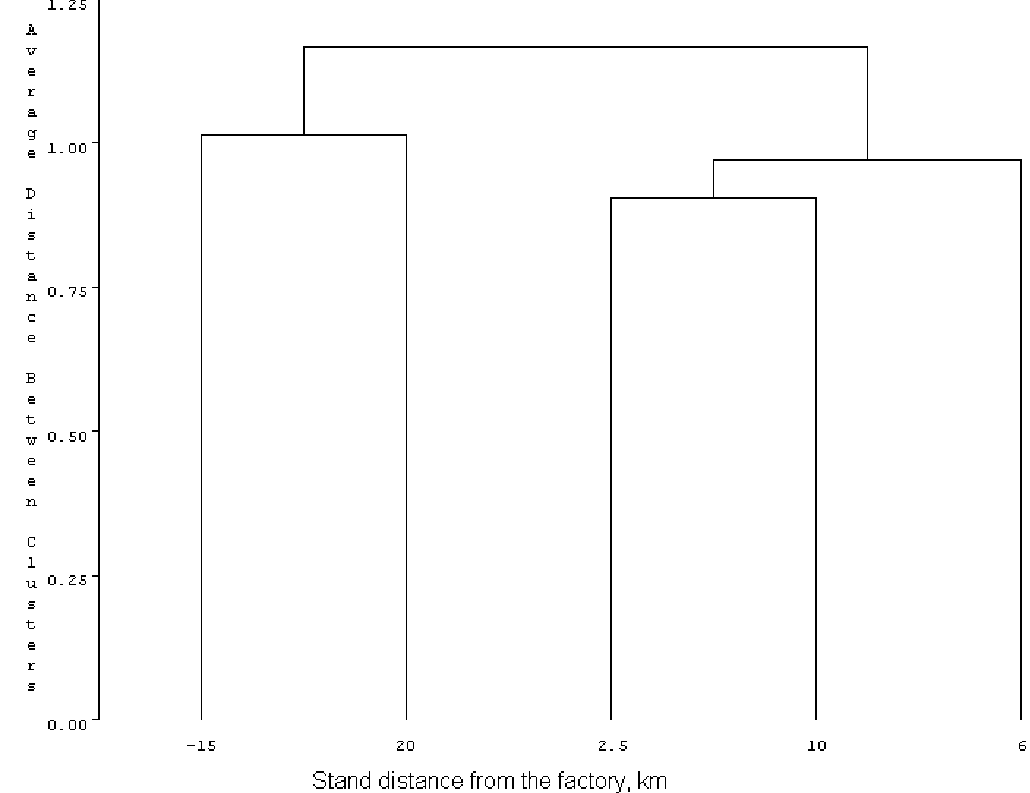
FIGURE 6 . Grouping of Scots pine ( P. sylvestris L.) stands growing at different distances from the nitrogen fertilizer factory according to percentage composition (n = 4) of the components (71) of essential oils in current-year needles (July 10,